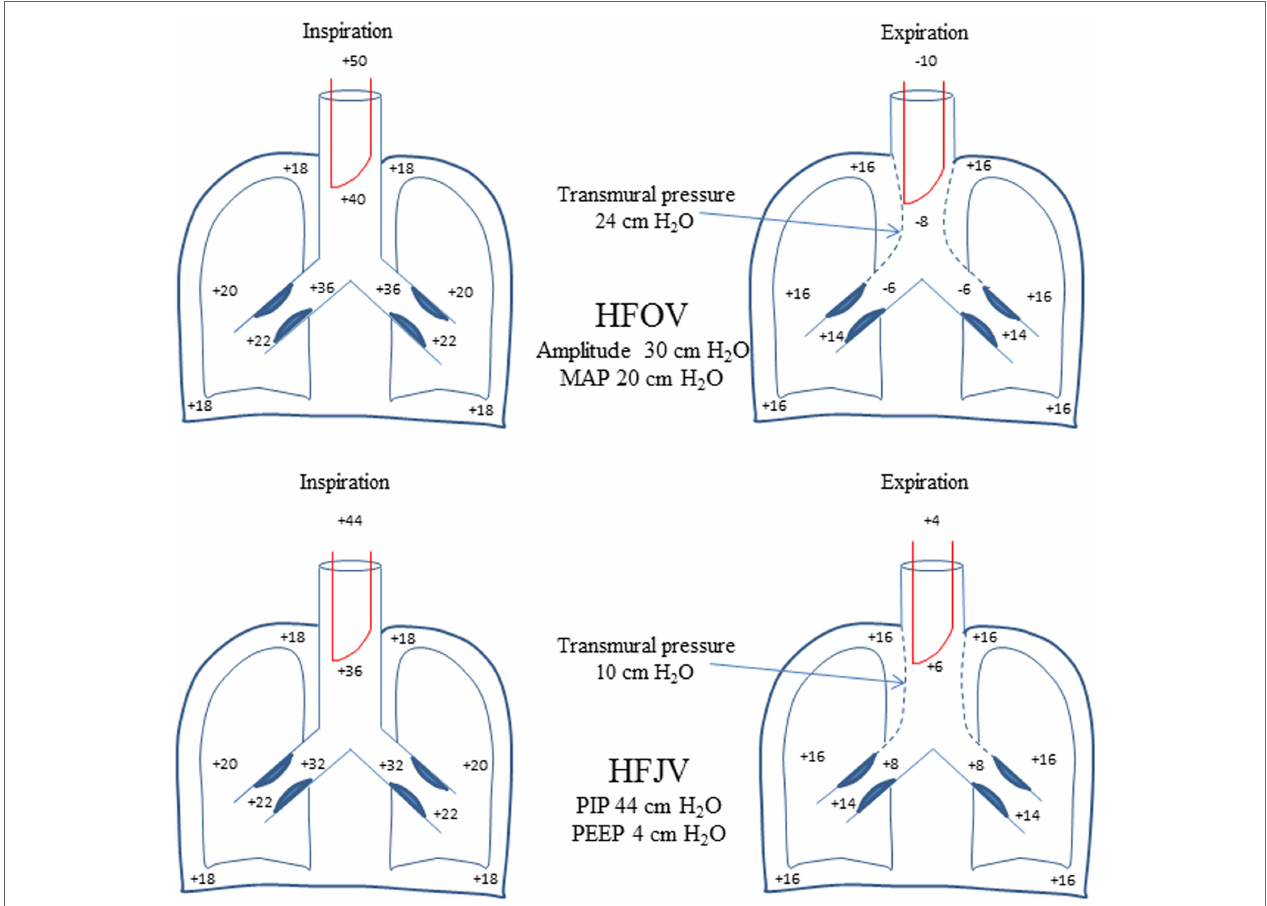
FigUre 2 | schematic comparison with theoretical pressures reflecting dynamic changes in airway caliber during hFOV and hFJV . The active exhalation of HFOV with negative intraluminal pressure is expected to result in greater increase in transmural pressure compared with passive exhalation of HFJV where intraluminal pressure remains positive throughout exhalation. This would lead to greater collapse of the proximal airway and higher expiratory resistance and air trapping especially in an obstructive disease (such as RSV bronchiolitis) in HFOV compared with HFJV. Transmural pressure equals intrapleural pressure minus airway (alveolar) pressure. See text for further